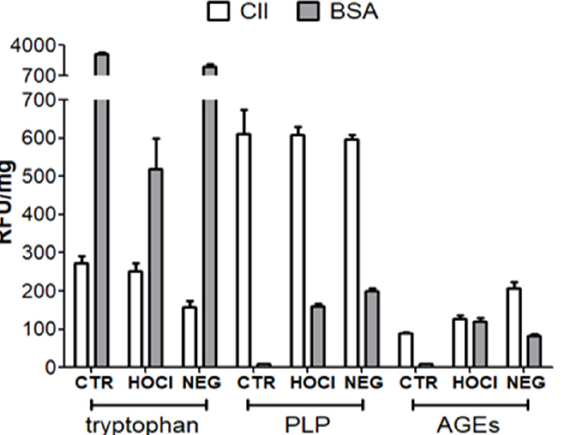
Figure A2. Fluorescence intensity of HOCl-CII and NEG-CII at wavelengths to detect tryptophan, PLP and AGEs compared with unmodified CII and the control changes in BSA. The bars represent the mean and standard error of the mean (SEM) of at least 3 independent experiments.